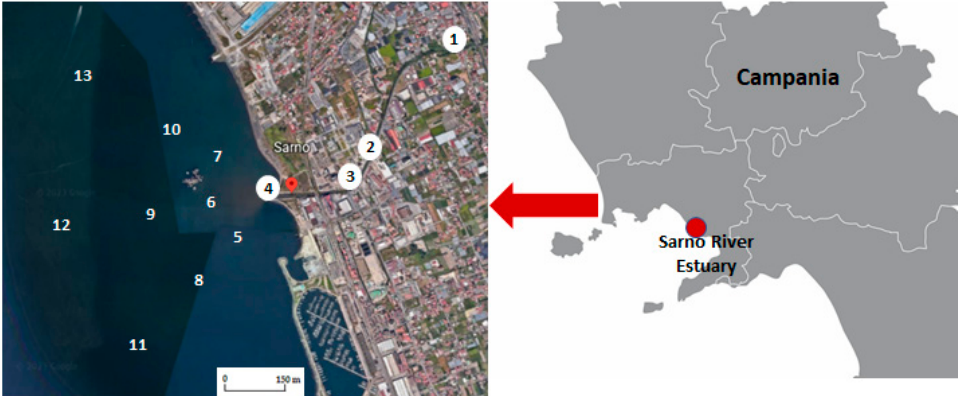
Figure 3. Hydrographic network and sampling sites near the Sarno River. Table 2. Sampling sites with their identification number (ID), location name, and coordinates from the Sarno River.